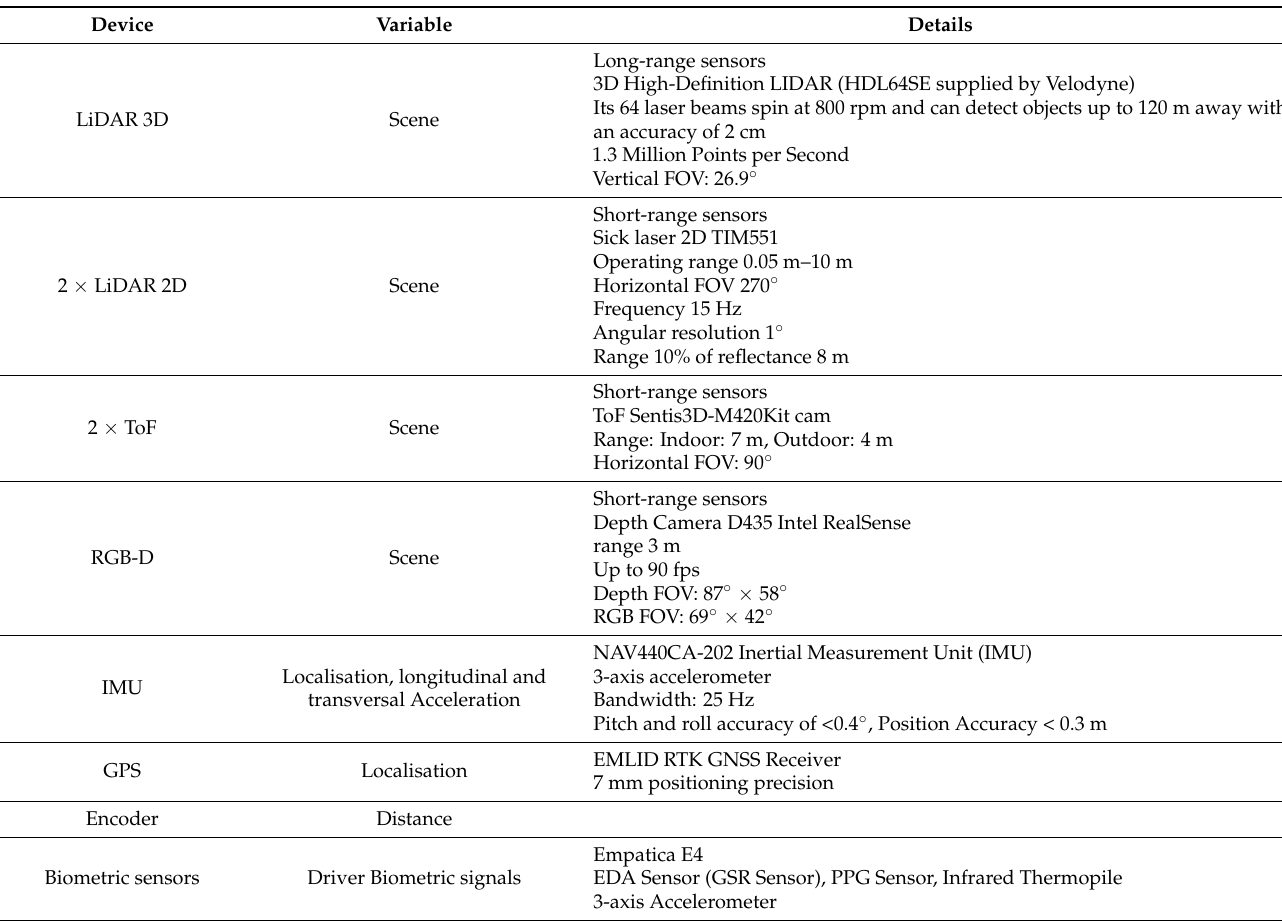
Table 3. Sensor data in